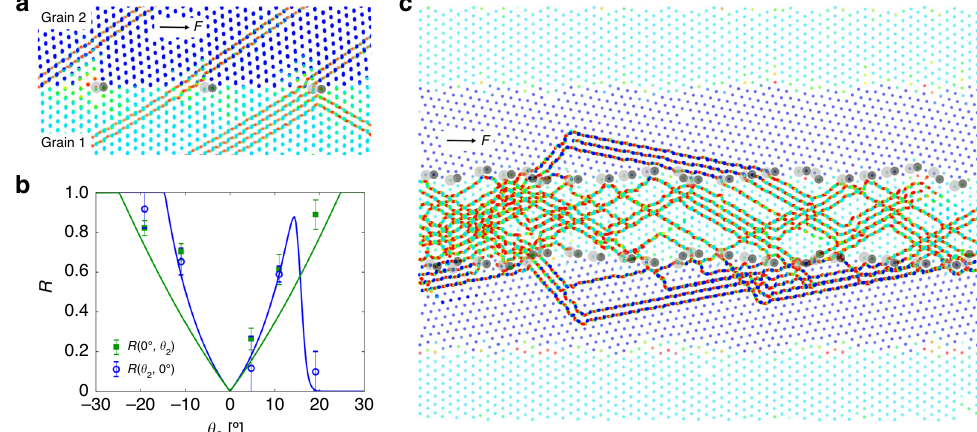
Fig. 4 Re fl ection of interstitial by nonsymmetric GBs. a Superposition of particle positions near a GB ( θ 1 = 0°, θ 2 = 4.72°) over 80 s time periods, trajectories of three interstitials ( w = 2, 2, 4 respectively) are clearly revealed. The particles are color coded like in Fig. 2. The 5 – 7 pairs at the GB are highlighted. F = 66 fN. b The re fl ection rates as a function of θ 2 for R (0°, θ 2 ) and R ( θ 2 , 0°), F = 66 fN. Points are experimental data. Lines represent Eq. (2) with parameters b = 4.6 µ m, k B T = 4.14 zJ. R (0°, θ 2 ) is much larger than R ( θ 2 , 0°) when θ 2 > 15°, this makes it possible to con fi ne interstitials within grain 1. Error bars are standard deviations of the data points. c The superposition of particle positions in a striped pattern in experiments over a 1000 s time period. The 5 – 7 pairs at the GB of the inner stripe are highlighted. F = 66 fN. The four GBs (from bottom to top) have GB angles (0°, − 19.1°), (19.1°, 0°), (0°, 19.1°) and ( − 19.1°, 0°),